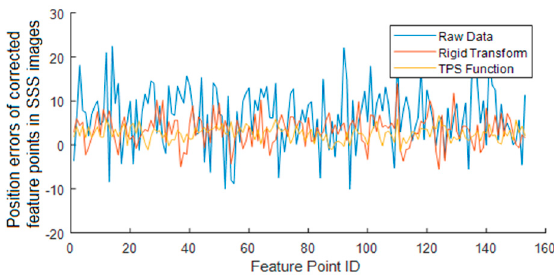
Figure 15. Positional errors of entire feature points of the raw SSS image and SSS images corrected using the rigid transform and TPS, respectively. Table 1. Statistical parameters of positional errors of entire feature points in the raw SSS image and SSS images corrected using the rigid transform and TPS, respectively.